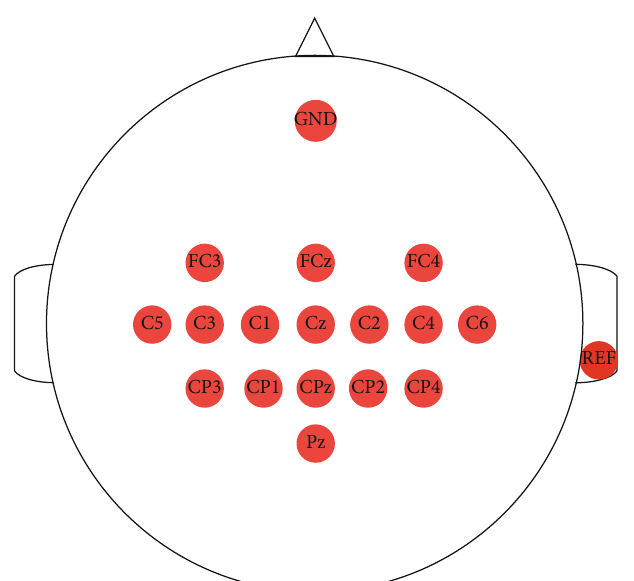
Figure 1: The electrode distribution used in this study.